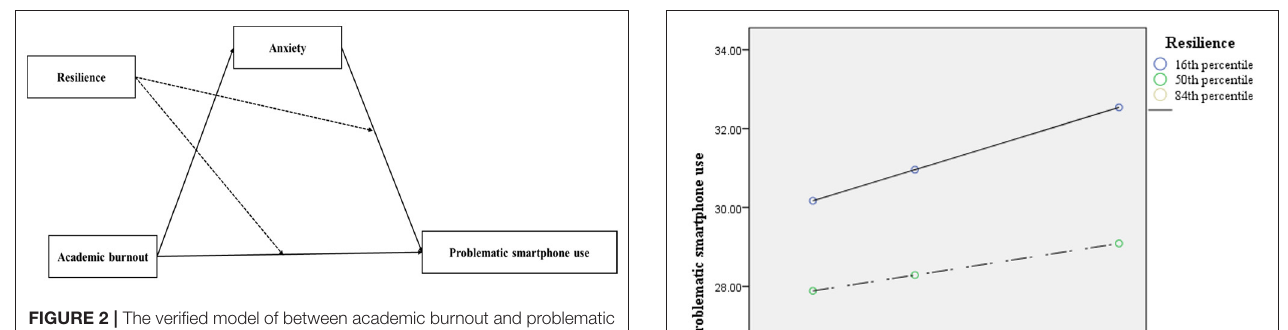
FIGURE 2 | The verified model of between academic burnout and problematic smartphone use ( N = 748). The study found that acadmic burnout positively predicted problematic smartphone use both directly and indirectly via anxiety. Resilience significantly moderated between academic burnout and problematic smartphone use and between anxiety and problematic smartphone use.